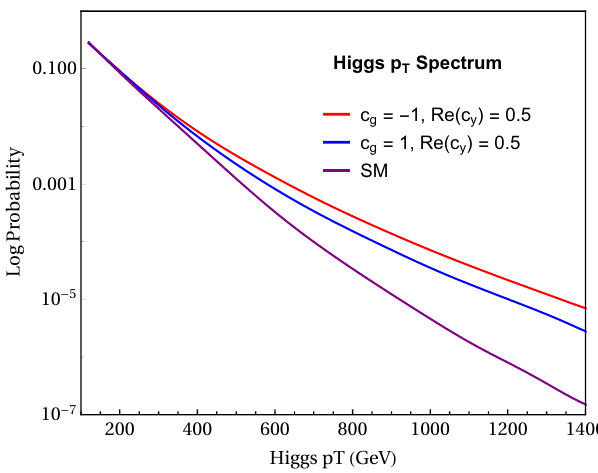
Figure 11 . Typical hardening of the p T spectrum of the Higgs for nonzero values of the Wilson coe(cid:14)cient c g , de(cid:12)ned in the